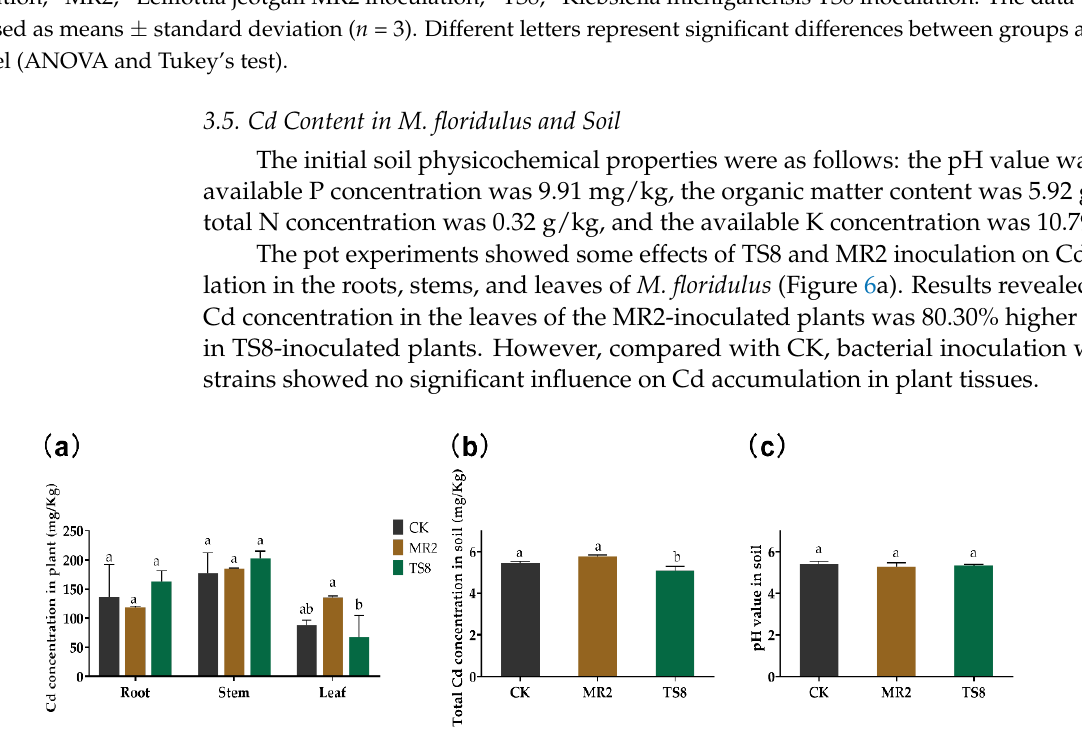
Figure 5 . Influence of inoculation with TS8 and MR2 on M. floridulus height ( a ) and dry weight ( b ). “CK,” without PGPB inoculation; “MR2,” Lelliottia jeotgali MR2 inoculation; “TS8,” Klebsiella michiganensis TS8 inoculation. The data were expressed as means ± standard deviation ( n = 3). Different letters represent significant differences between groups at the 5% level (ANOVA and Tukey’s test).